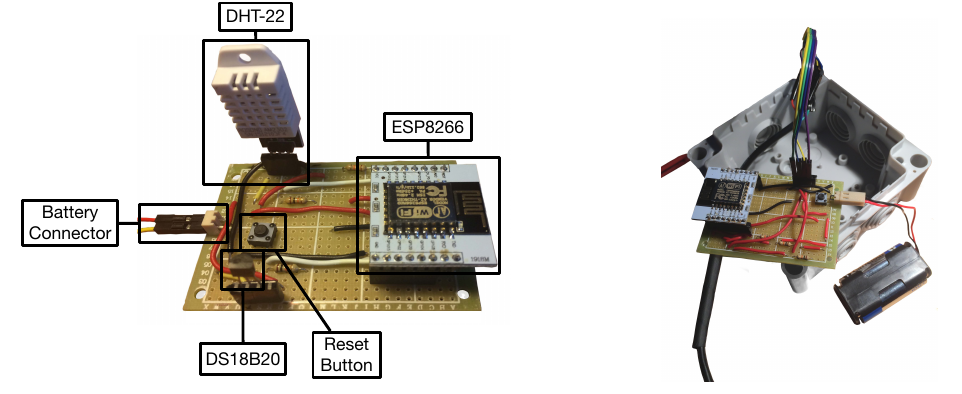
Figure 4. Type-1 node out of the box ( left ) and encapsulated ( right ).